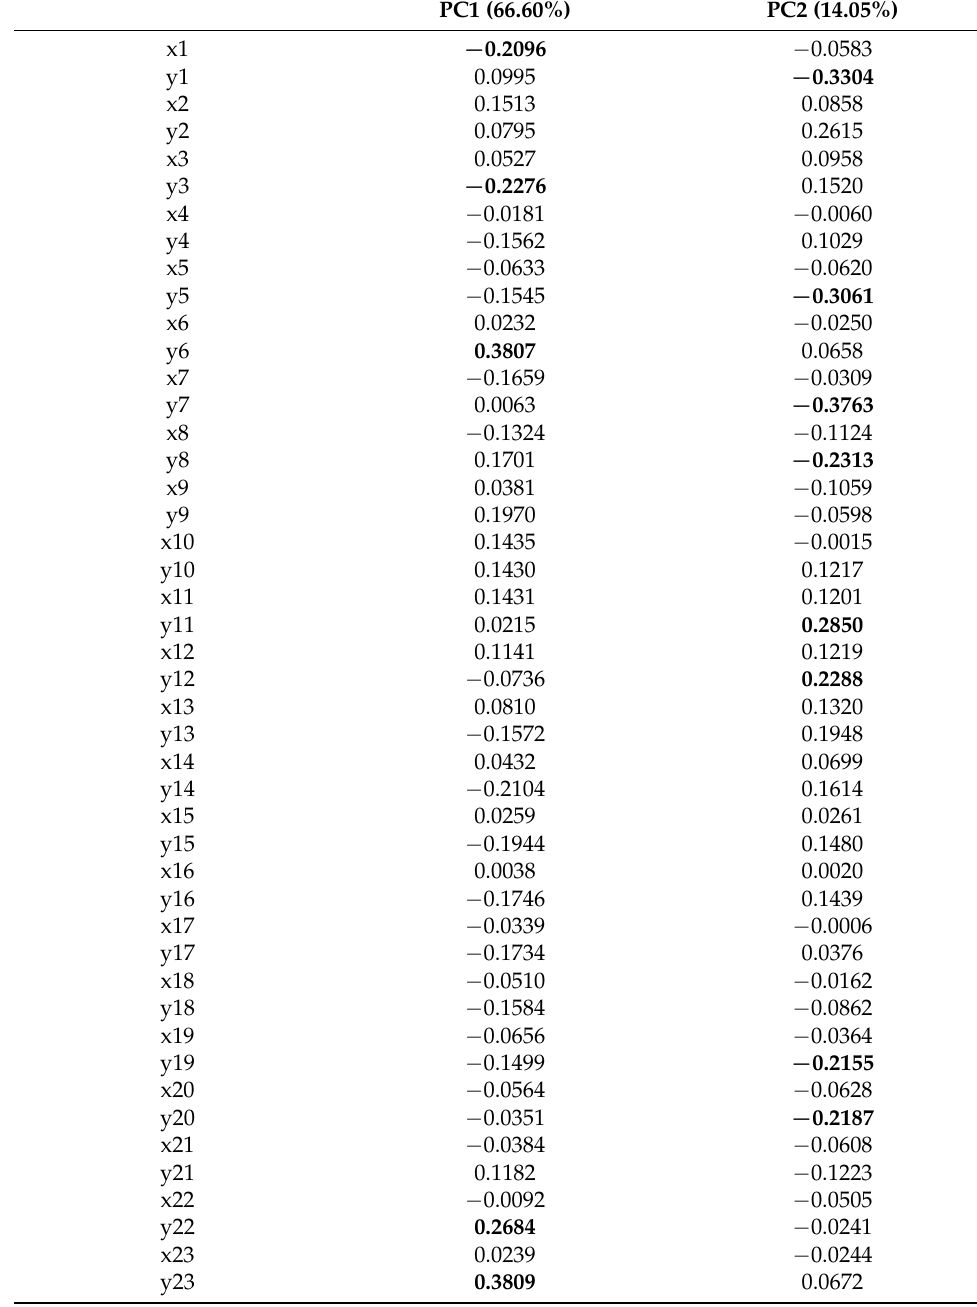
Table 1. Results for Principal Component Analysis. The first two Principal Components (PC) accounted for 80.65% of the total variance observed (PC1 + PC2 = 66.60% + 14.05%). The 14 anatomical semi-landmarks with the highest discriminative value (>[0.2]) appear in bold. PC1 (66.60%) PC2